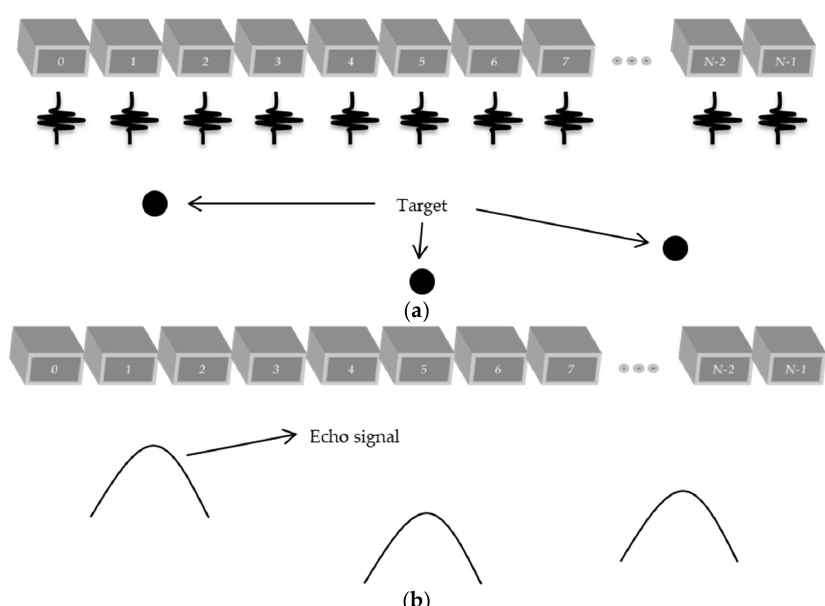
Figure 1. Plane wave technique: ( a ) All transducer elements are simultaneously excited to generate ultrasonic waves that reach the targets on the media to be analyzed; ( b ) Echo signals reflected on the targets and returning to all transducer elements.